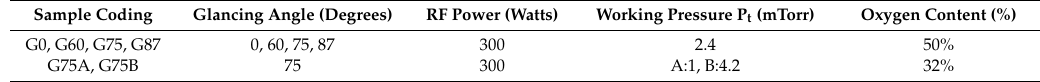
Figure 1. Substrate geometry with respect to target surface for glancing angle depositions. Table 1. Samples nomenclature and deposition